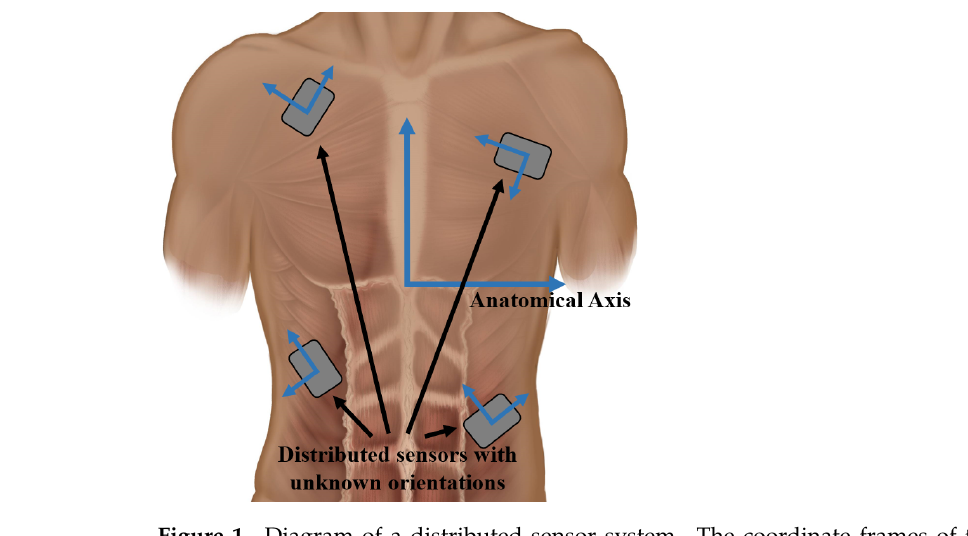
Figure 1. Diagram of a distributed sensor system. The coordinate frames of these sensors are unknown relative to the body’s anatomical coordinate frame.